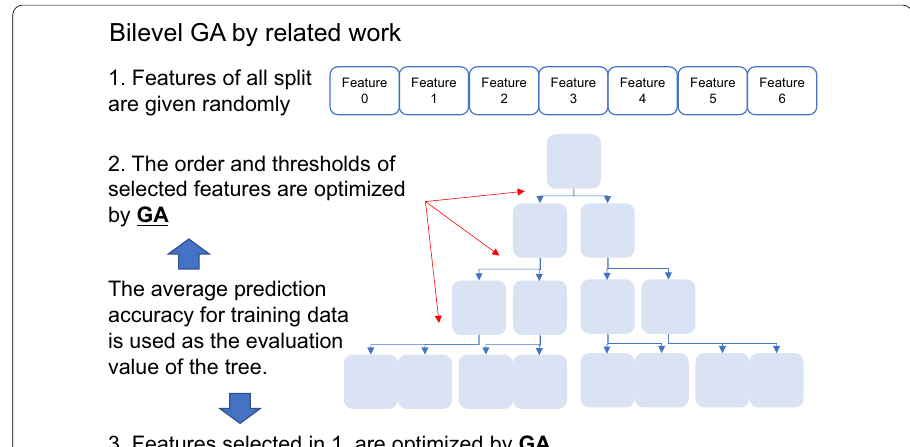
Fig. 1 Outline of bilevel genetic algorithm (GA) used in related works